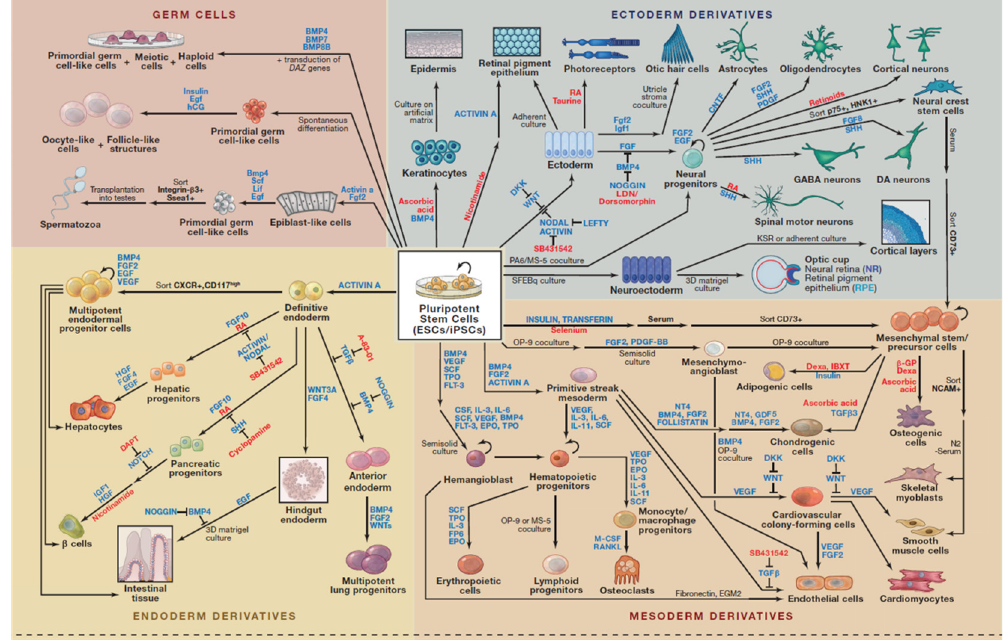
Figure 1. Directed Differentiation of Pluripotent Stem Cells [8]. Highlighted here are some of strategies for directing the differentiation of Embryonic Stem Cells (ESCs) and induced pluripotent stem cells (iPSCs) into defined cell types. Most cell types and pathways depicted correspond to published work on human cells, expect for the production of spermatozoa, oocyte-like cells, otic hair cells, cortical layers, and optic cup, which were generated with mouse ESCs or iPSCs. This figure is reproduced from Williams, Davis-Dusenbery and Eggan [8]; published by Elsevier under open-access license policies.